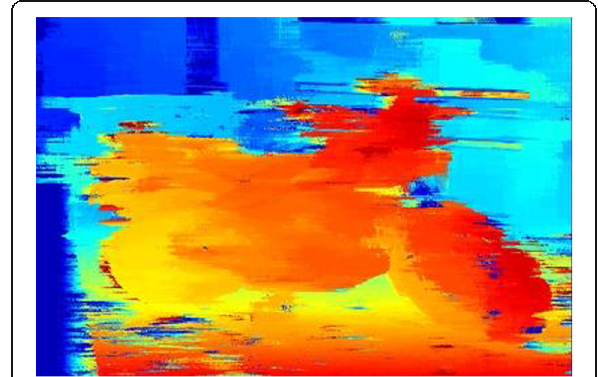
Fig. 5 Disparity image produced using the MNS1 method. MNS1 is able to reconstruct the shapes and spatial locations of the objects in the scene. This method produces significantly less noise than other presented methods